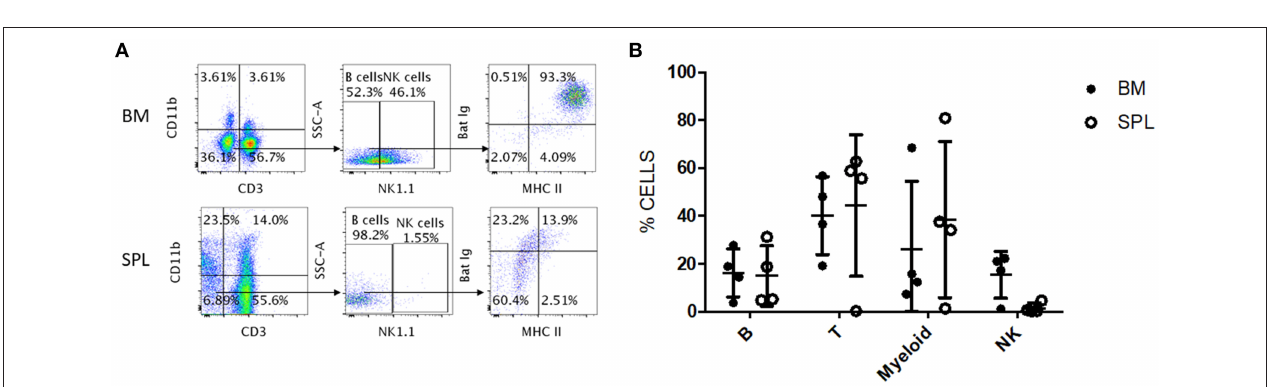
FIGURE 6 | Calcium Release Assay. Bone marrow cells (BM), splenocytes (SPL), PBMC and lymph nodes (LN) from P. alecto bats ( n = 3) were processed for calcium release assay as described in M&M. Cells treated with Ionomycin were used as positive control and cells stained without anti-bat Ig were used as negative control. (A) Lymphocytes were gated based on forward and side scatter distribution. B cells, T cells and myeloid cells were gated as CD11b − MHC-II + , CD11b − MHC-II − , and CD11b + MHC-II − , respectively. One data set is shown and is representative of 3 independent experiments performed with 3 different bat spleens and lymph nodes. (B) Percentage of cells in BM, SPL, PBMC, and LN undergoing calcium influx after treatment with Ioniomycin, or with or without anti-IgG Ab. * p < 0.05.